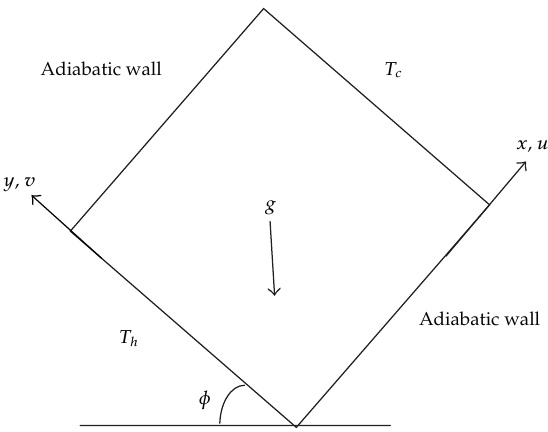
Figure 1: Schematic diagram of the physical model and coordinate